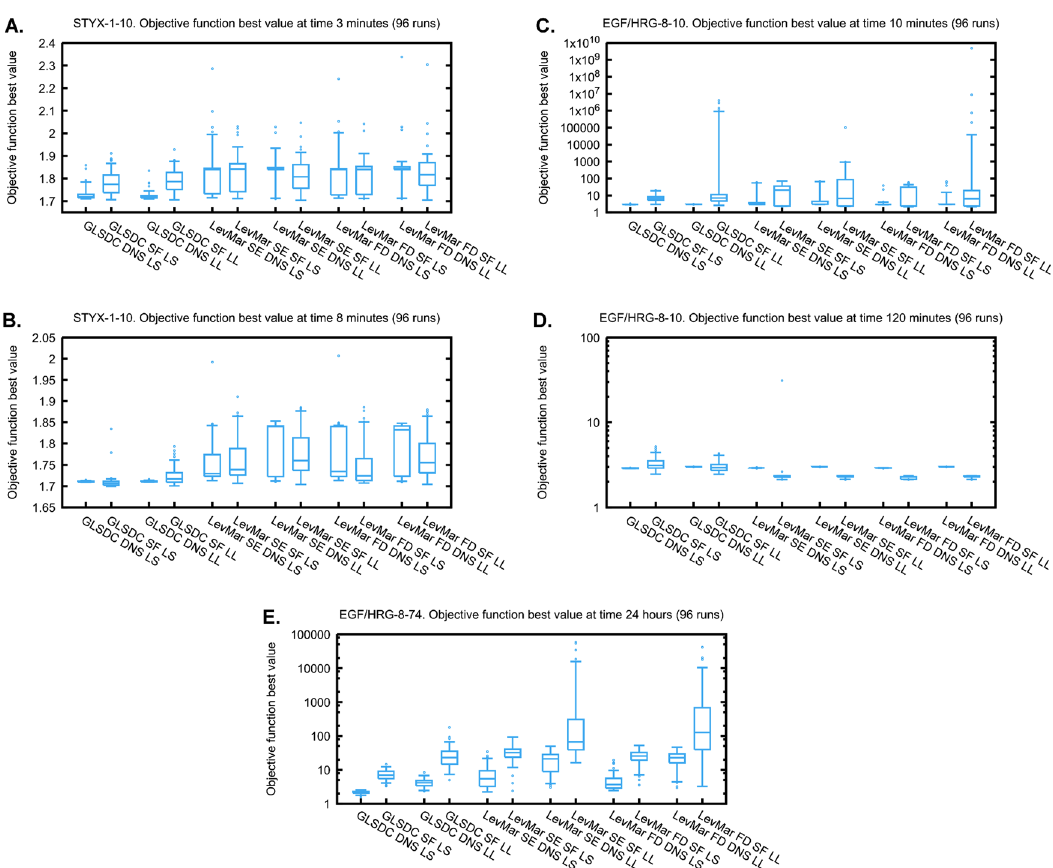
Fig. 5 Minima reached by different algorithm-objective function combinations after a set time for a , b the STYX-1-10 problem, c , d the EGF/HRG-8-10 problem and e the EGF/HRG-8-74 problem. Times are a after 3 min, b after 8 min, c after 10 min, d after 2 h and e after 24 h of optimising. Boxplots as in Fig 1. DNS data-driven normalisation of the simulations, LL log-likelihood, LS least squares, SF scaling factors. To facilitate the comparison, we always report the LS values on the y axis, even when LL was